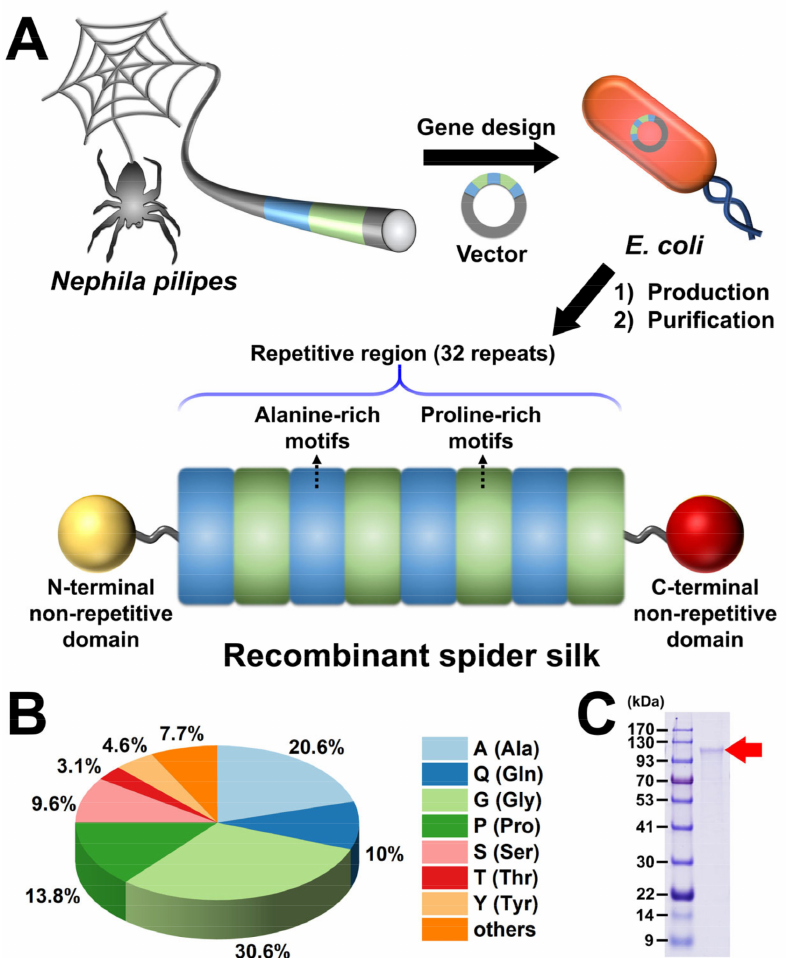
Figure 1. Schematic illustration of design for the recombinant spider silk. ( A ) Production and the modular structure of recombinant spider silk. ( B ) Amino acid sequence ratio of the recombinant spider silk. ( C ) The protein size of the recombinant spider silk, visualized by SDS-polyacrylamide gel electrophoresis